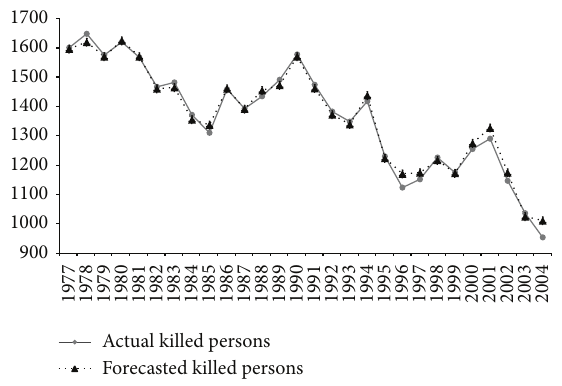
Figure 3: The actual and forecasted values of killed persons.